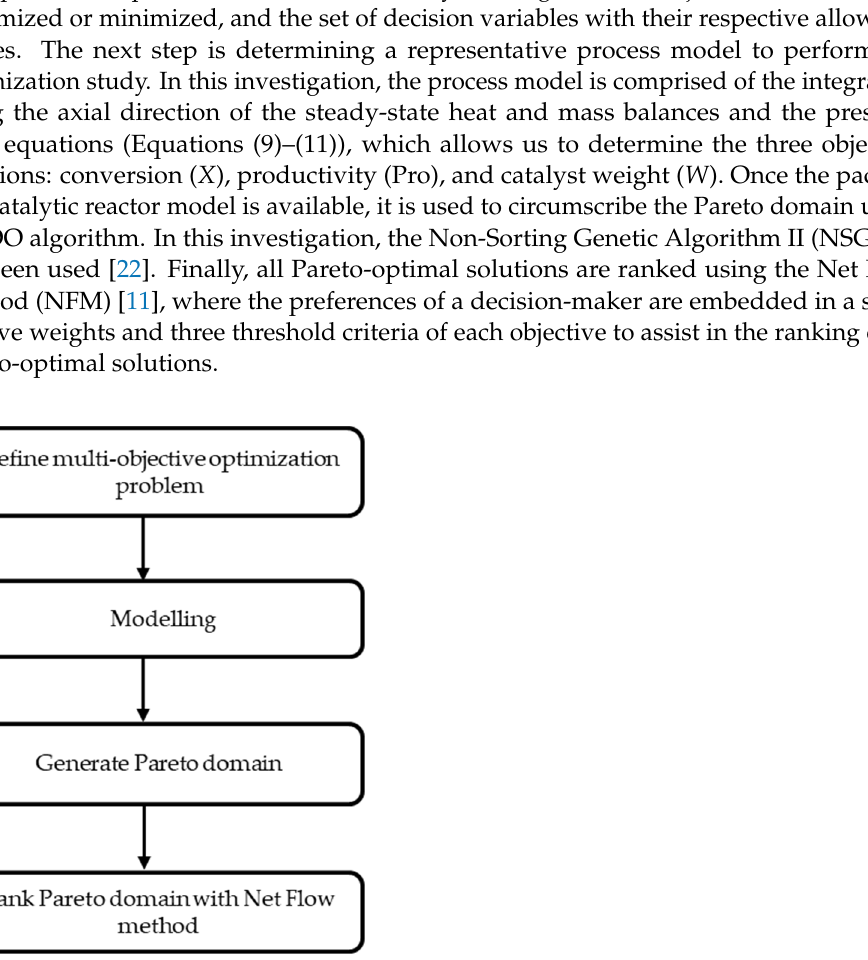
9 of 23 Table 3. Reactor system simulation parameters. Parameter